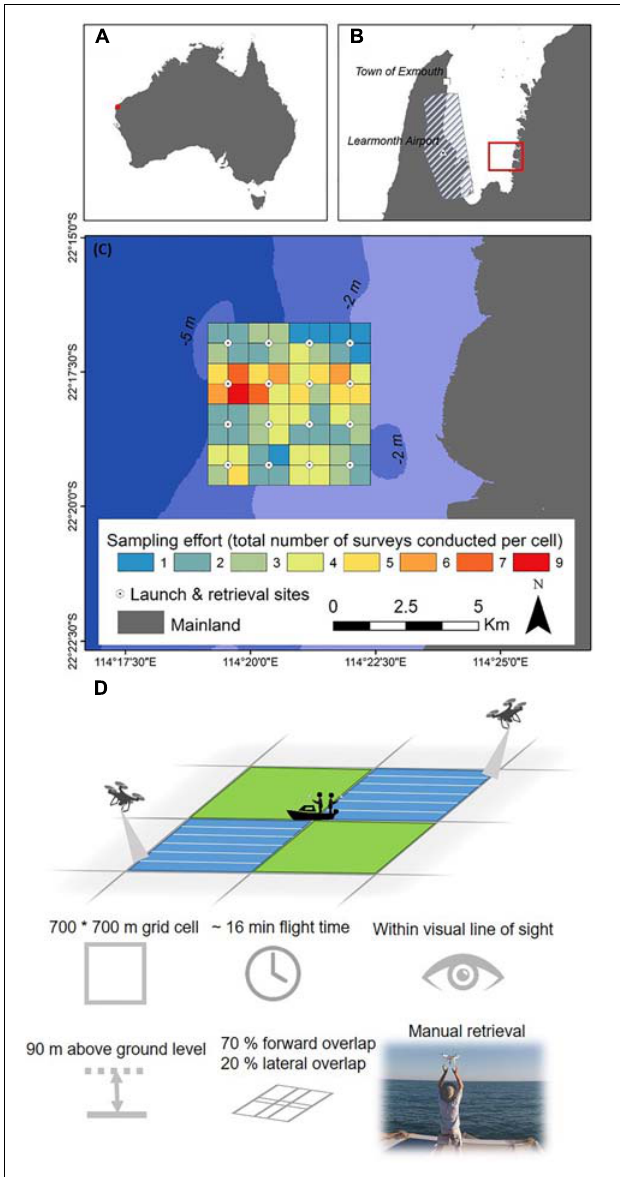
FIGURE 1 | (A,B) Study site location (in red; hashed polygon represents controlled air space); (C) survey grid and sampling effort (the blue shaded layer represents the bathymetry); (D) diagrammatic representation of a grid survey operation and flight parameters, the green and blue cells can all be surveyed from the same launch and retrieve location (the vessel location); in this scenario the blue cells are surveyed simultaneously by using two UAVs.